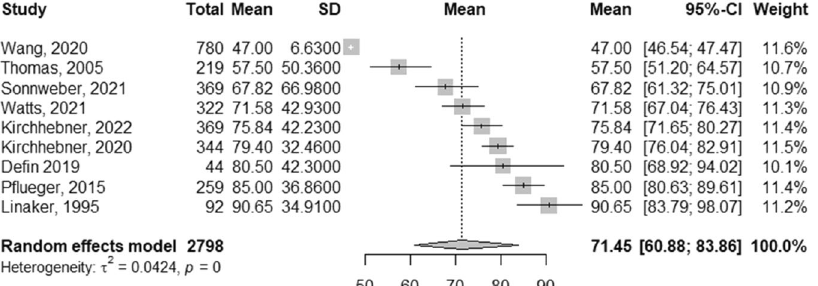
Fig. 2 Pooled effects of model accuracy. Pooled accuracy of criminal and violent models in psychiatry across 2428 patients (two studies used the same sample n = 370) within a random effects model using a restricted maximum likelihood estimator to calculate the heterogeneity variance τ 2. Reported mean accuracy across models was used, in conjunction with standard deviation, calculated by multiplying the standard error by the square root of the sample size (SD = SE× √ n ). Knapp-Hartung adjustments were used to calculate the con fi dence interval around the pooled effect. The average accuracy across models was 71.45% (95% CI: 60.88 – 83.86), with a heterogeneity variance τ 2 of